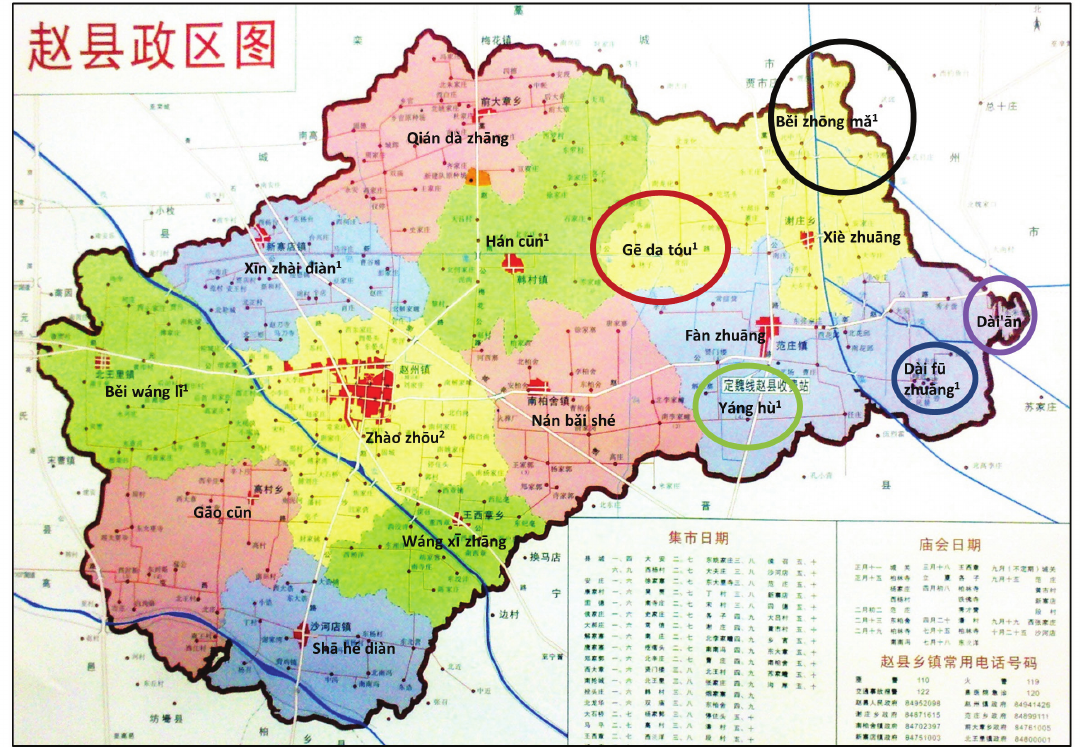
Figure 1. Map of Zhào County 赵县 . The map shows 11 coloured areas. For the nine townships on the left side of the map, these nine areas correspond with the nine townships: Beˇi wáng lıˇ 北王里 (green left upper area), Gaˉo cuˉn 高村 (red left middle area), Shaˉ hé diàn 沙河店 (blue left lower area), Xıˉn zhài diàn 新寨店 (blue middle upper area), Zhào zhoˉu 赵州 (yellow central area), Wáng xıˉ zhaˉng 王西章 (green middle lower area), Qián dà zhaˉng 前大章 (red left upper area), Hán cuˉn 韩村 (green right upper area), Nán baˇi shé 南柏舍 (red right lower area). However, the two areas on the right side of the map correspond with seven townships: the two township areas (Xicˇ zhuaˉng 谢庄 (yellow right upper area) and Fàn zhuaˉng 范庄 (blue right lower area)) and five townships that are marked with circles. The five circles correspond with the areas of the five townships and the names of the townships are written in the middle of the circles. Superscripts above the townships indicate when they are covered in survey 1 or in the remaining study. Townships for survey 1: Hán cuˉn 韩村 (green right upper area), Yáng hù 杨户 (around the green circle), Beˇi zhoˉng maˇ 北中马 (around the black circle), Beˇi wáng lıˇ 北王里 (green left upper area), Xıˉn zhài diàn 新寨店 (blue middle upper area), Geˉ da tóu 圪瘩头 (around the red circle), Dài fuˉ zhuaˉng 大夫庄 (around the blue circle). Township for remaining study: Zhào zhoˉu 赵州 (yellow central area). Figure is the courtesy of Shuyi Zhang, personal collection.